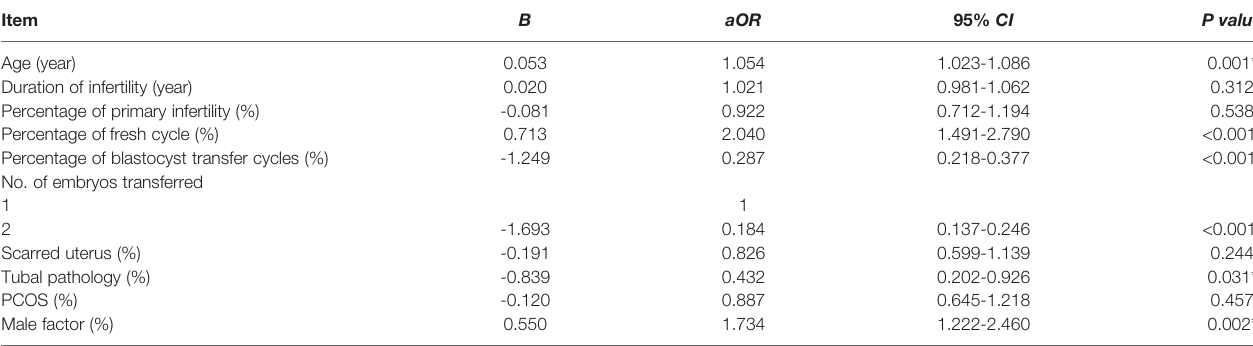
TABLE 2 | The comparison of associated factors of patients with two vs three or more implantation failure by logistic regression analysis. Item